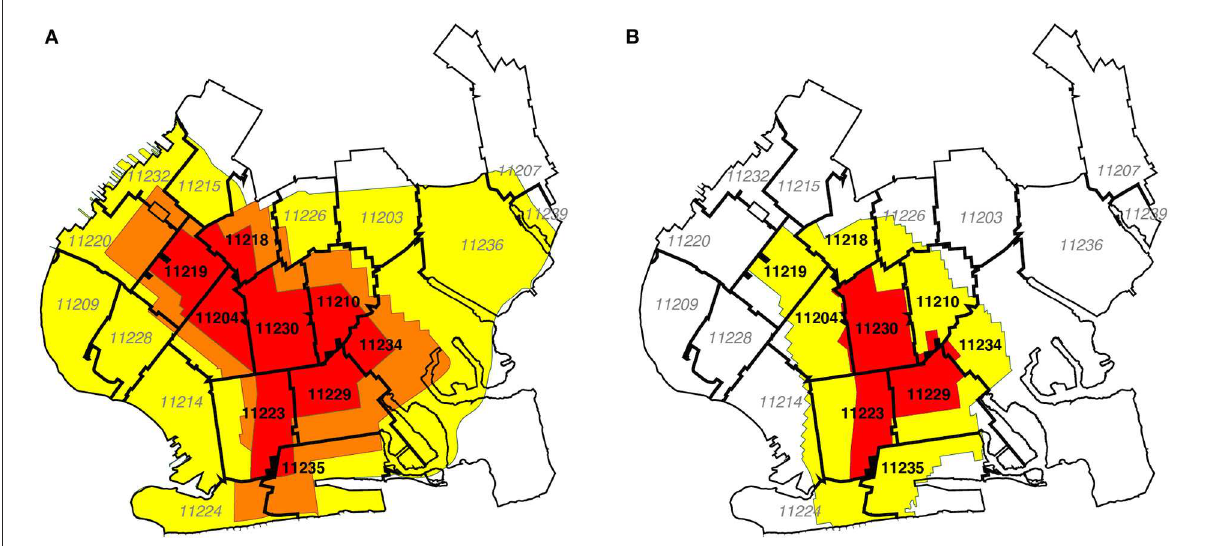
FIGURE2 (A) Boundaries of the original October 9 zones overlaid on map of zip code tabulation areas (ZCTAs). In our calculations of confirmed COVID-19 incidence rates and test positivity rates, we assigned the nine ZCTAs in black boldface to the original red zone, while the remaining 12 ZCTAs in gray italic were assigned to the combined orange and yellow zones. (B) Updated boundaries of the redrawn November 3 zones overlaid on the same ZCTA Map. For base map of New York City ZCTAs, see Ref. (33).